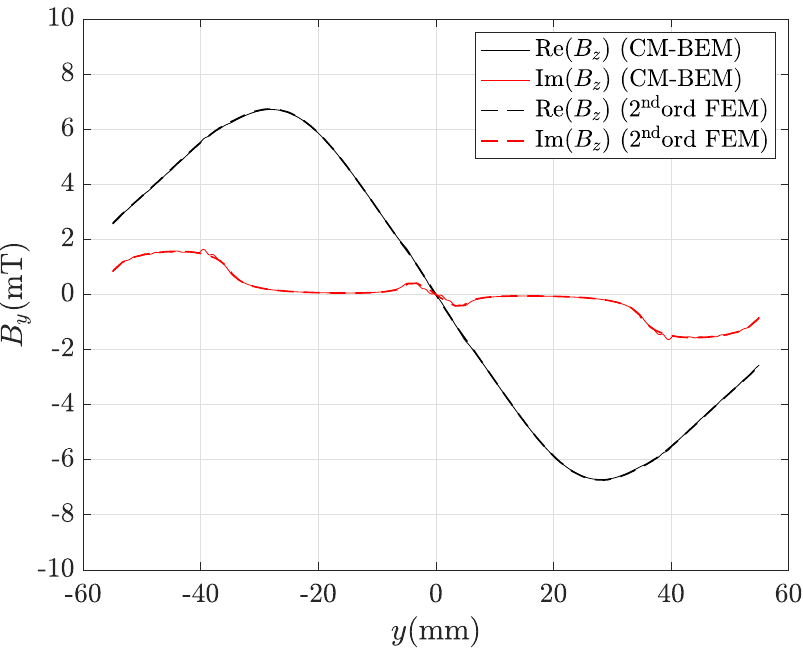
Figure 13. Real and imaginary parts of the y -axis magnetic flux density component at 50 Hz along the line A-B (indirect CM–BEM plot is in straight line, FEM plot is in dashed